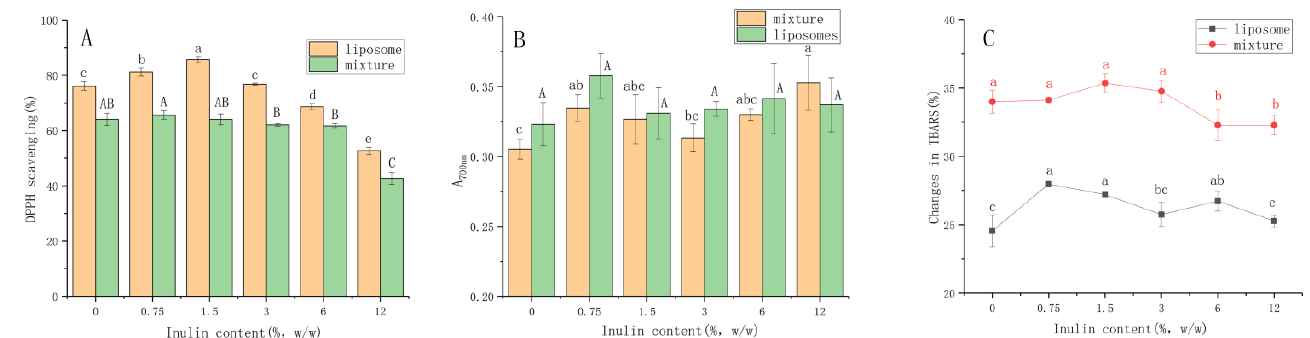
Figure 6. ( A ) DPPH radical scavenging ability; ( B ) Ferric reducing ability (A 700 nm ); ( C ) Changes in TBARS of different concentrations of inulin modified cinnamaldehyde liposomes and the mixture of cinnamaldehyde-inulin-DMSO solution and blank liposomes. Results are represented as the mean ± sd (n = 3). Different letters represent a significant difference ( p < 0.05). DPPH: 2,2-diphenyl- 1-picryl-hydrazyl; TBARS: thiobarbituric acid-reactive substances; DMSO: dimethyl sulfoxide.